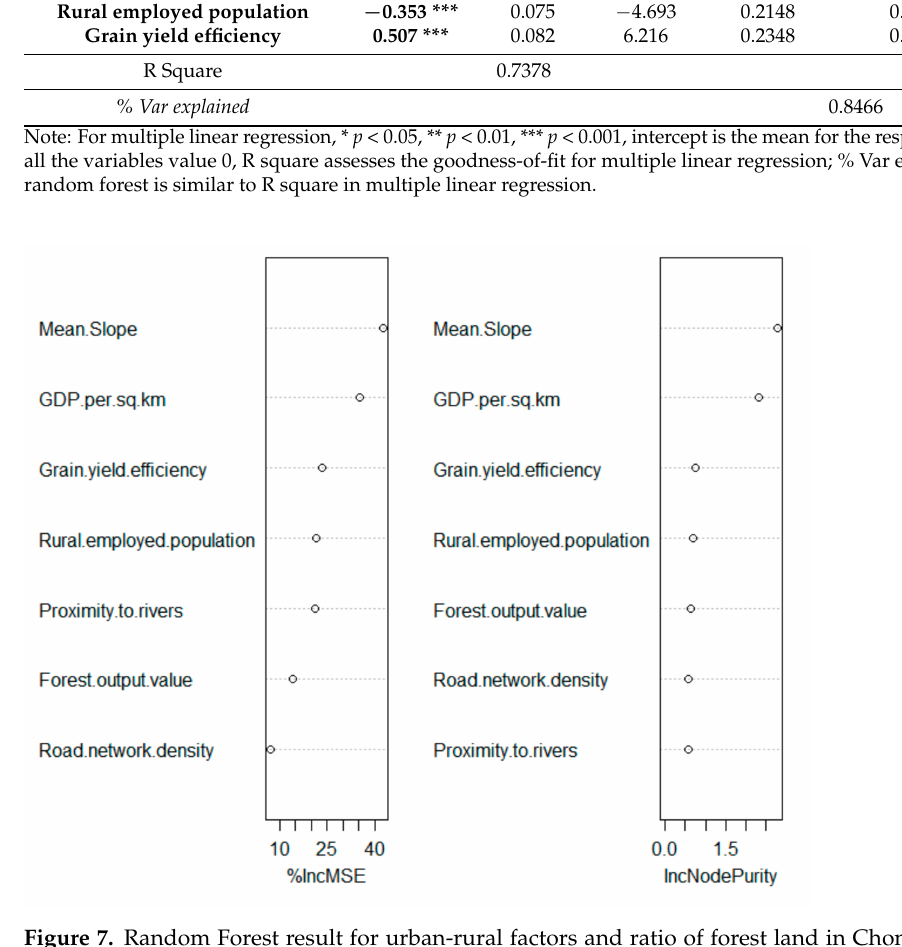
Figure 7. Random Forest result for urban-rural factors and ratio of forest land in Chongqing (in- creased importance from bottom to